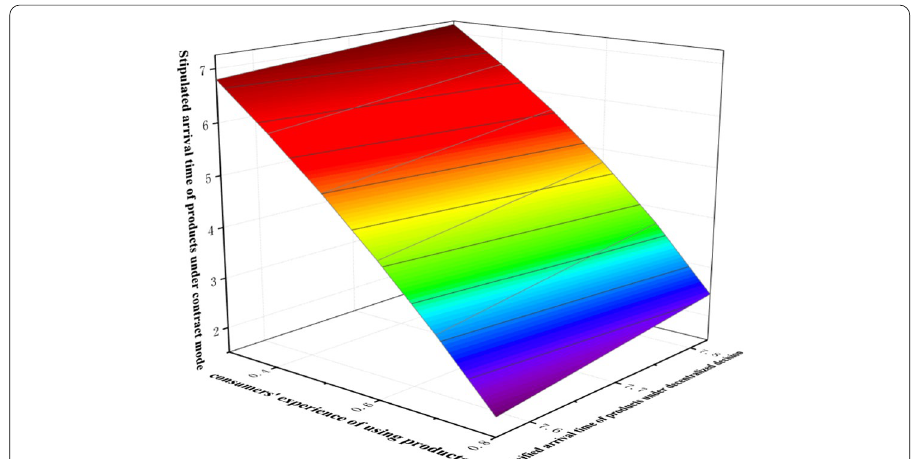
Fig. 4 Change of product arrival time T with consumer’s experience in using products